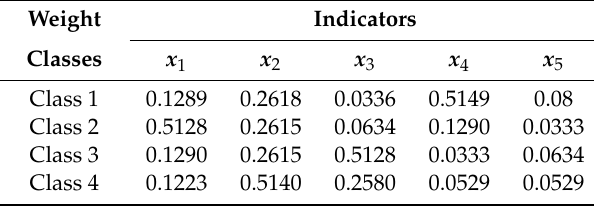
Table 12. The weight of each indicator within classes in the light of the analytic hierarchy process (AHP).